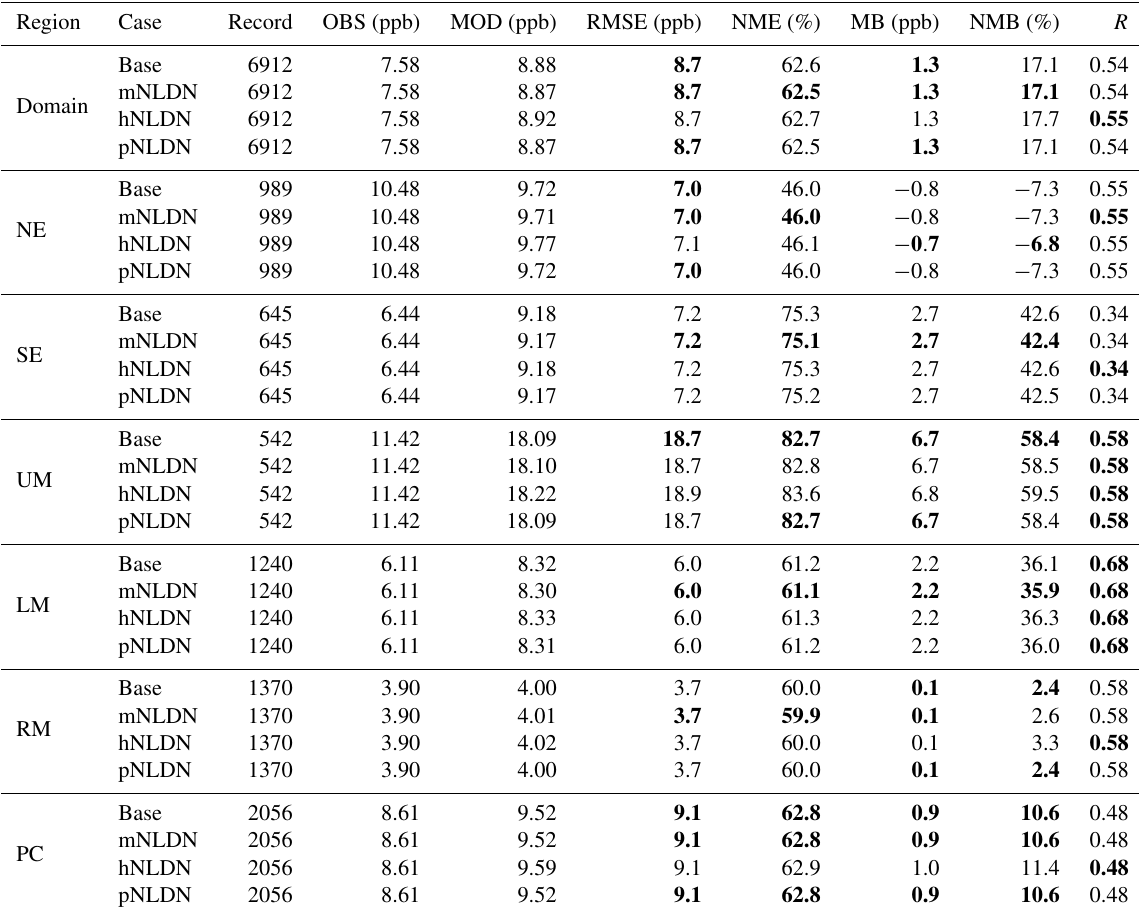
Table 2. Statistics of daily mean NO x for all model cases over the domain and analysis regions in July 2011. The best performance metrics among the model cases are highlighted in